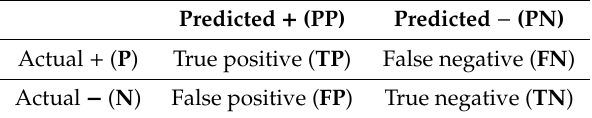
Table 3. Confusion matrix of observations in 2-class